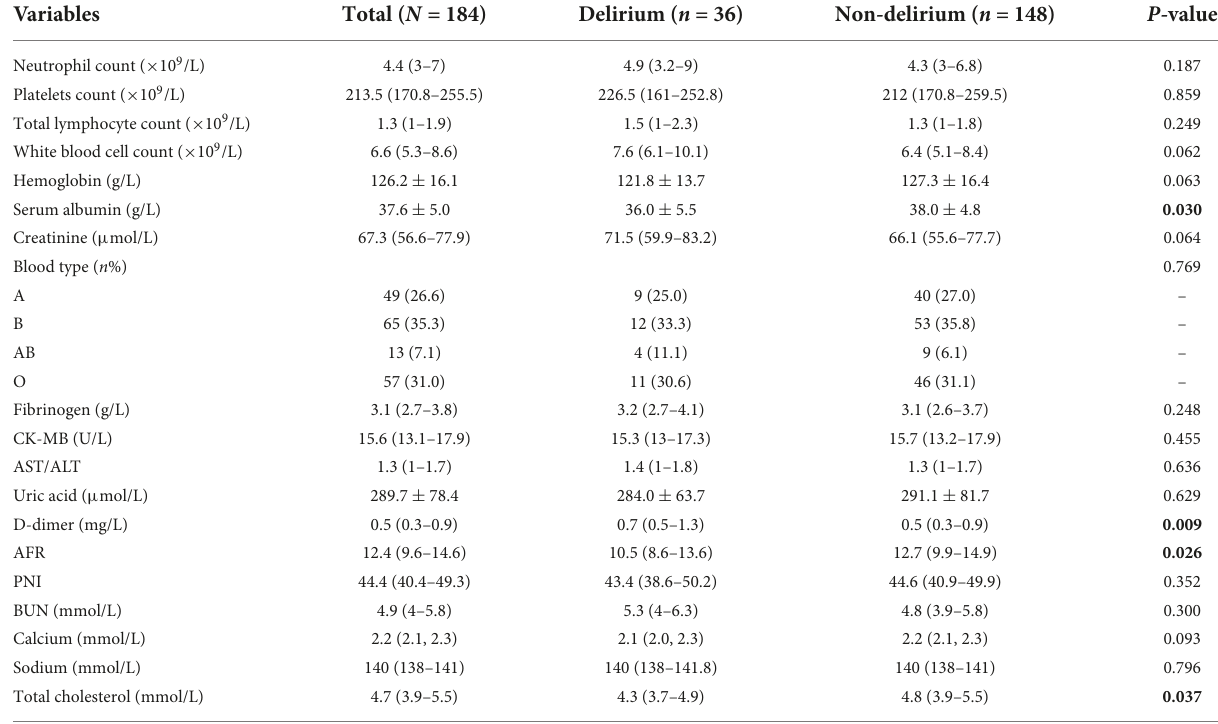
TABLE 2 Pre-operative laboratory variables in older patients with or without post-operative delirium (POD). Variables